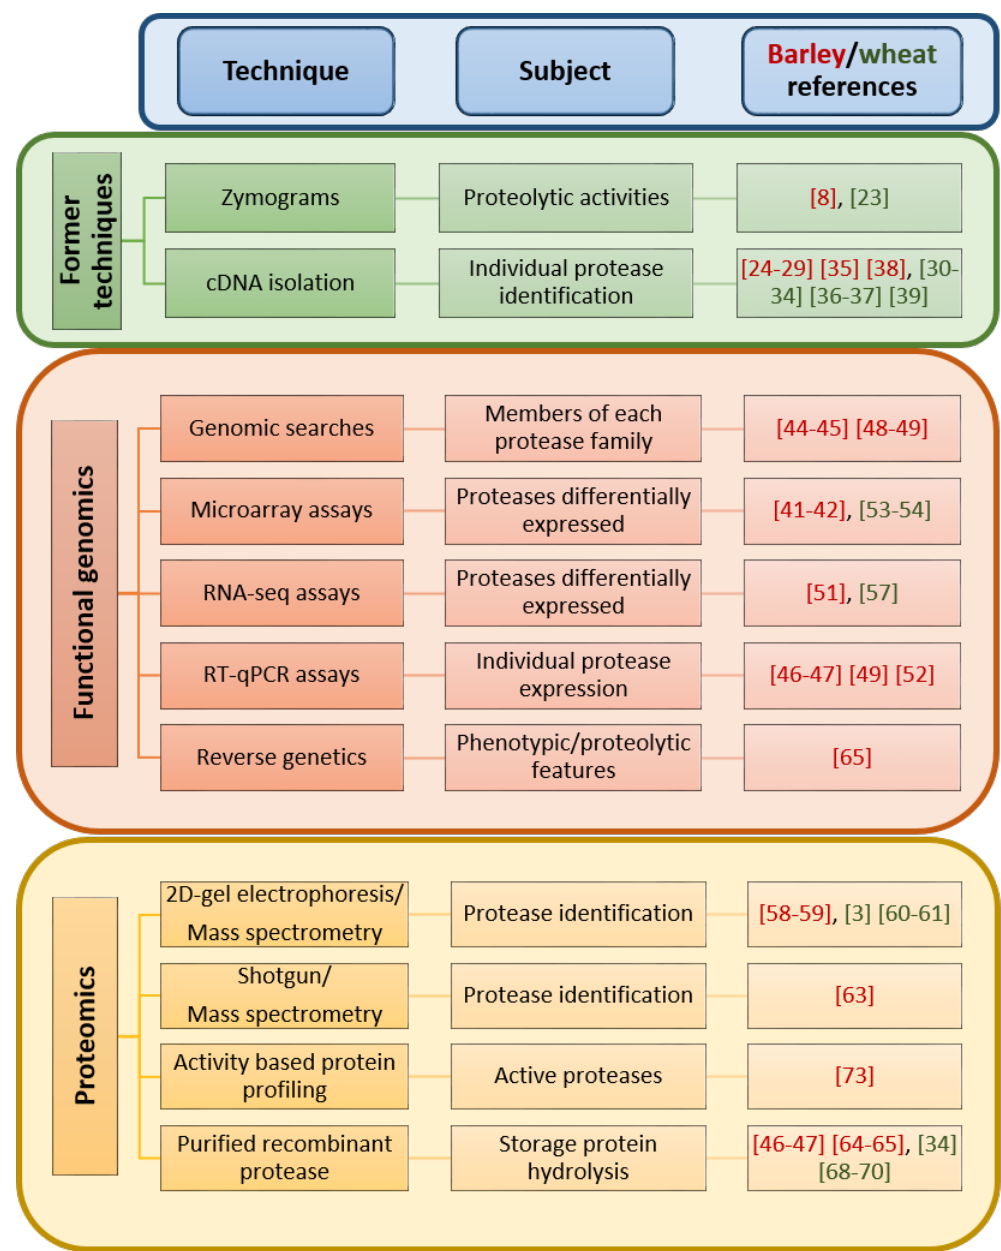
Figure 2. Global scheme of the main techniques used to analyze the implication of proteases during the germination of barley and wheat grains. 120